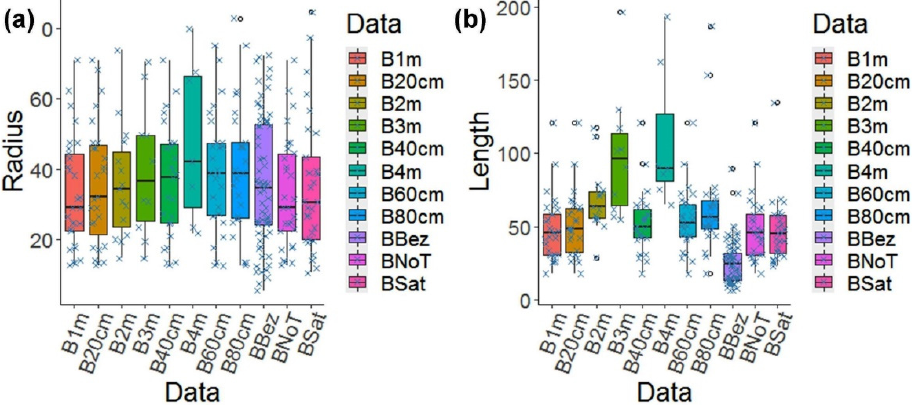
Figure 9. The mean curve radius ( a ) and length ( b ) values for the forest road and a box plot view of outliers.